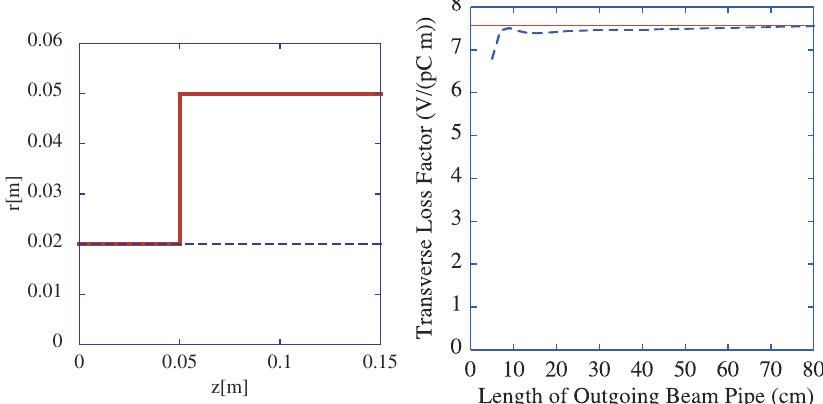
FIG. 4. (Color) Comparison between the present method and the conventional integration methods. The dashed straight line in the left figure shows the integration path for the conventional integration method. The horizontal axis of the right figure shows the length of the outgoing beam pipe. The red line represents the kick factor obtained by the present method, and the blue dashed line does that by the conventional method. About 20 times longer beam pipe than the aperture of the pipe is necessary to calculate the transverse wake potential